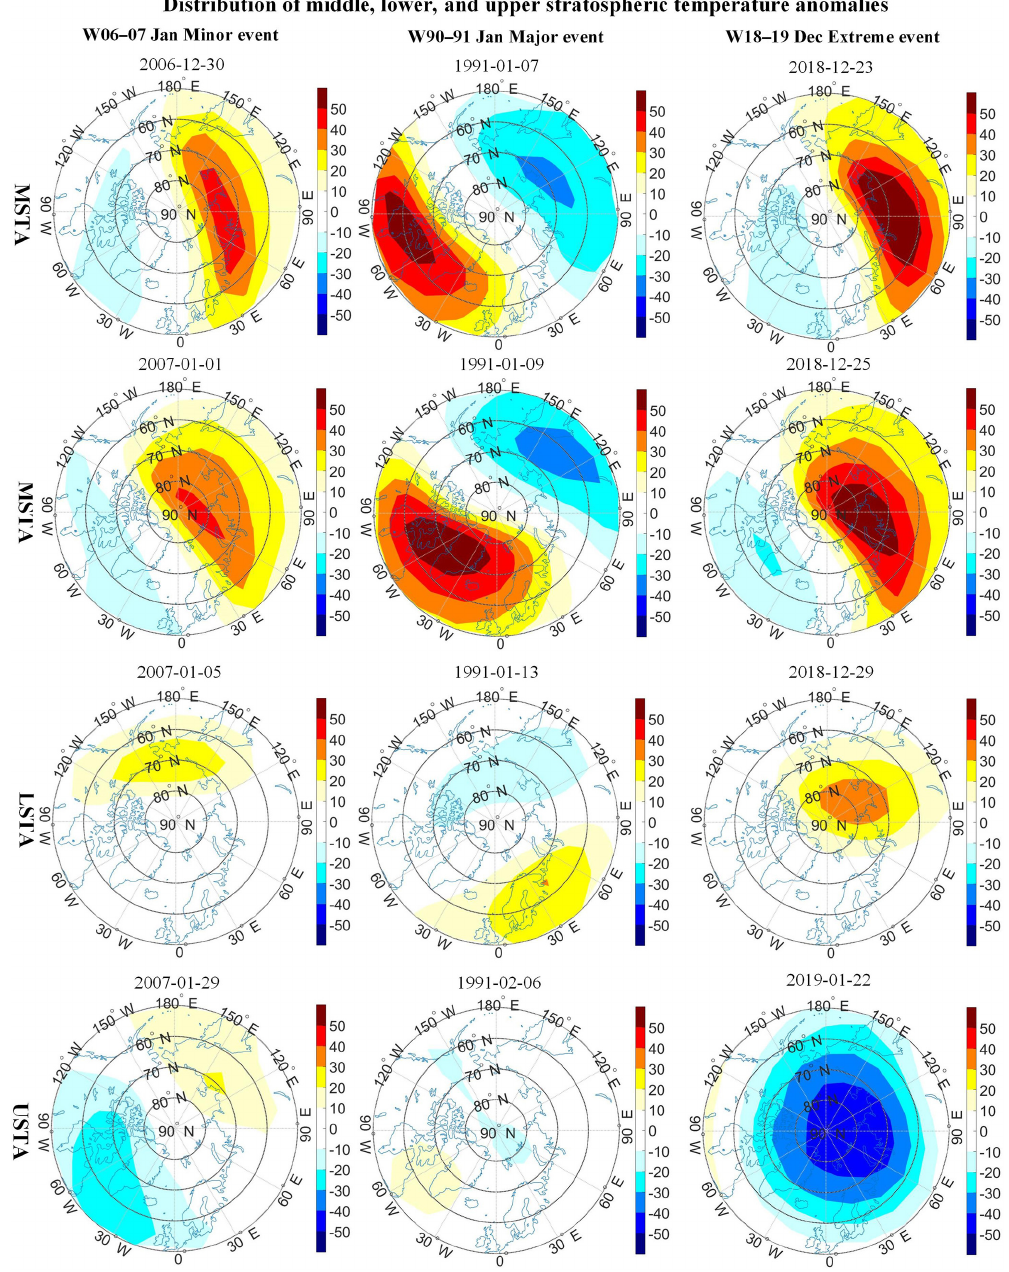
Figure 6. Polar-view (50–90 ◦ N) contour maps of W06–07 January minor (left panels), W90–91 January major (middle), and W18–19 December extreme (right panels) SSW example events (see Figs. 1 and 6), illustrating ERA5-based middle-stratosphere temperature anoma- lies (MSTAs), lower-stratosphere temperature anomalies (LSTAs), and upper-stratosphere temperature anomalies (USTAs). MSTAs (top and second row panels) are shown 2d before and on the defined onset date (see Table 2 for definition), LSTAs (third row panels) 4d after the onset date, and USTAs (bottom panels) 4 weeks after the onset date,